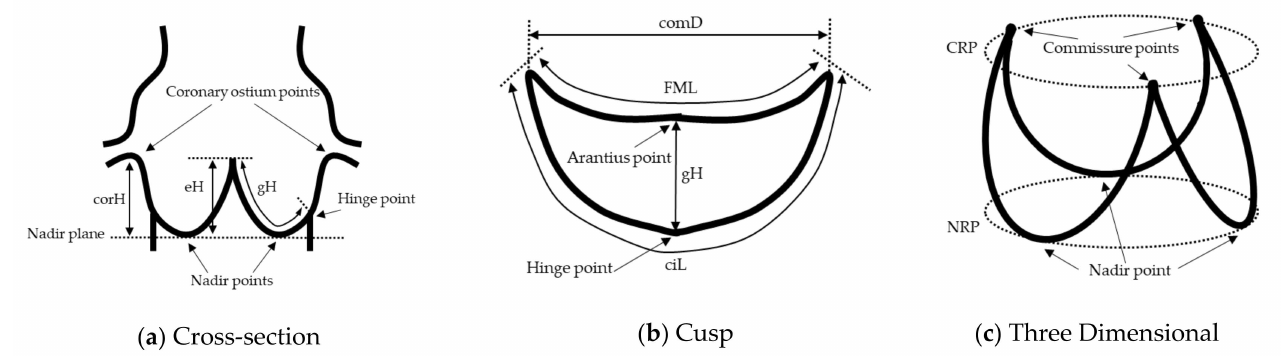
Figure 4. Schematic diagram illustrating the measurement position. ( a ) Cross-section, ( b ) Cusp, ( c ) Three